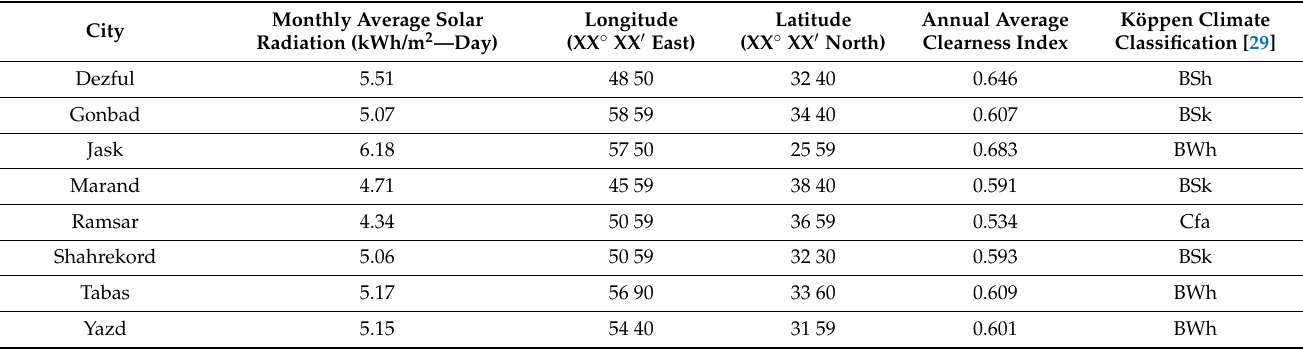
Table 2. Information of cities under